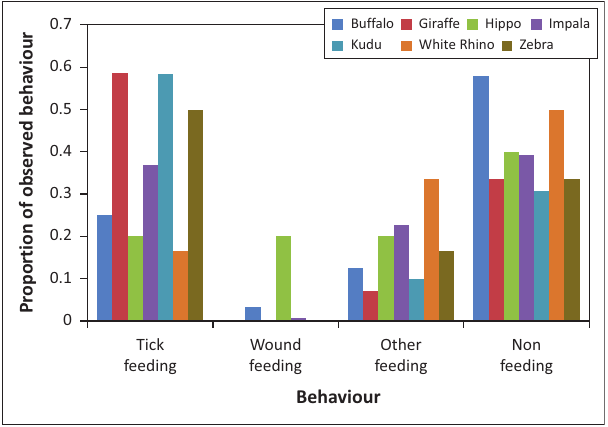
Tick Wound Other Non feeding feeding feeding Behaviour FIGURE 5: The frequency of Red-billed Oxpeckers’ behaviours on different ungulate host species in the Skukuza and Shingwedzi areas.